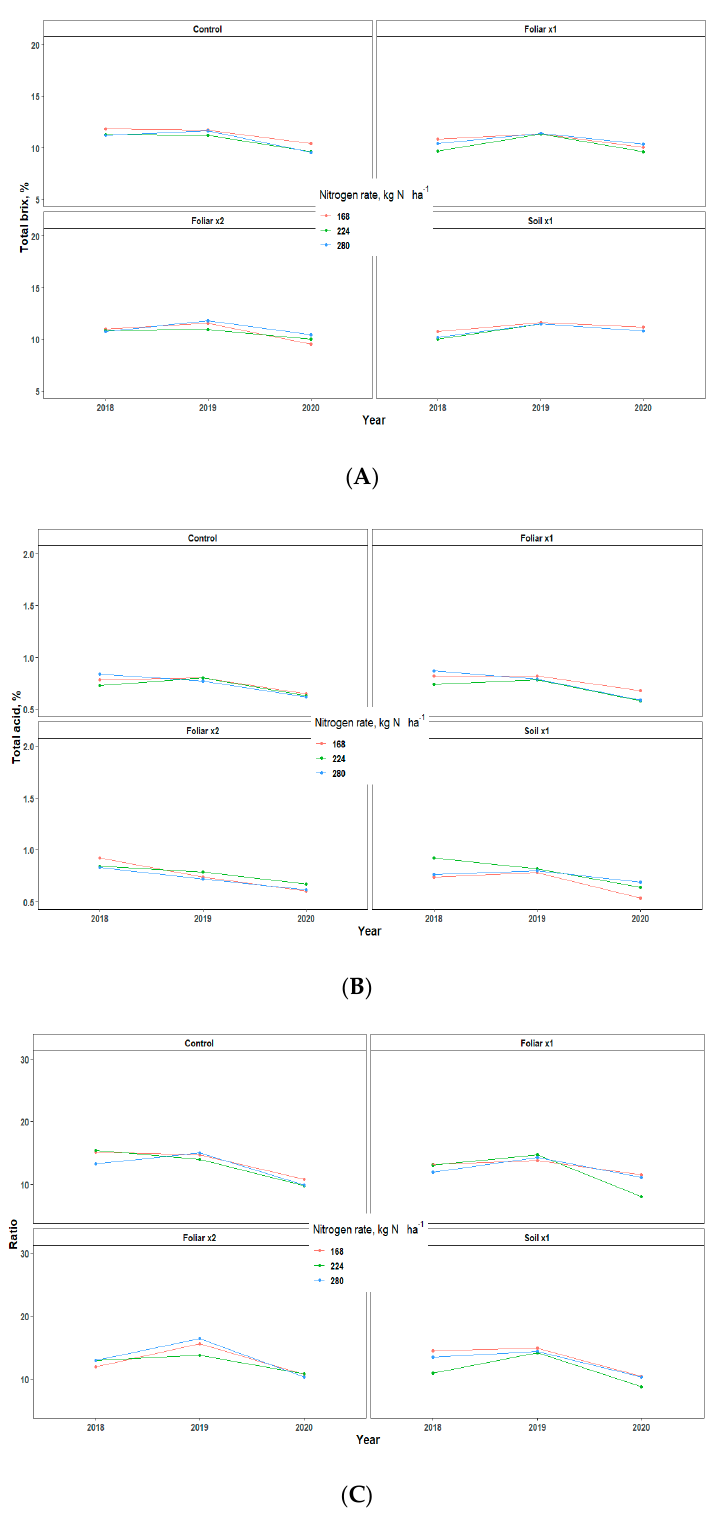
Figure 6. Juice quality assessment [Total brix ( A ), Total acid ( B ), and Ratio ( C )] of “Valencia” sweet oranges for in 2018, 2019 and 2020. Treatments: control—standard soil Zn applied; foliar x1—standard soil Zn applied + foliar-applied Zn based at 1× UF/IFAS recommendations; foliar x2—2× foliar-applied Zn at UF/IFAS recommendations + standard soil Zn application; soil x1—2× soil-applied UF/IFAS recommendations (5.60 kg Zn ha − 1 ). Table 3. Three years of fruit yield of Huanglongbing-affected “Valencia” sweet orange grove with standard error (n = 3) in Lake Alfred, Florida.